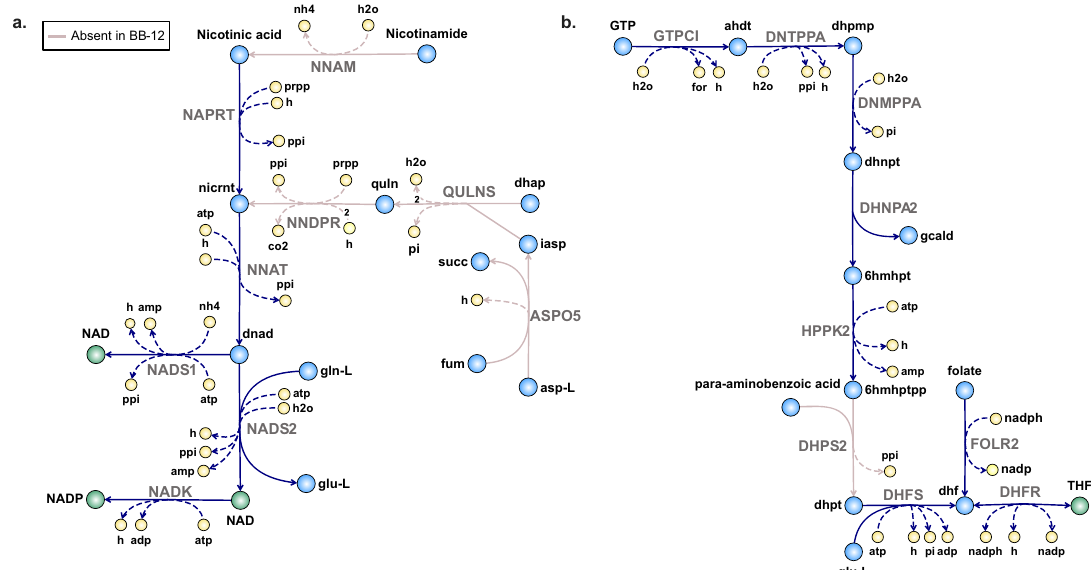
Fig. 5 NAD(P) + and tetrahydrofolate (THF) synthesis in BB-12 and BB-46. a Proposed pathways of NAD(P) + biosynthesis in BB-12 and BB-46: In contrast to BB-46, BB-12 lacks a gene coding for nicotinamidase (EC 3.5.1.19), which catalyzes the conversion of nicotinamide into nicotinic acid (NNAM), as well as genes required for biosynthesis of nicotinate D-ribonucleotide (nicrnt) from L-aspartate (asp-L) and fumarate (fum). b Proposed pathways of folate biosynthesis in BB-12 and BB-46: Both strains cannot synthesize para -aminobenzoic acid. BB-12 further lacks a gene coding for dihydropteroate synthase (EC 2.5.1.15), catalyzing the condensation of para -aminobenzoic acid and 6-hydroxymethyl- dihydropterin pyrophosphate (6hmhptpp) (DHPS2). Abbreviations of metabolite and reaction names are the same as used in the models (Supplementary Data 3 and